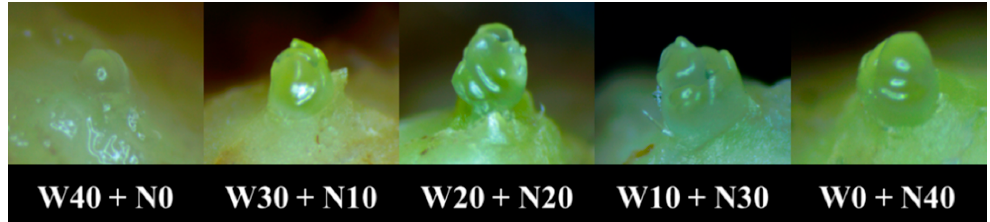
Figure 2. Microscopic view of flower bud development stages on the apical meristem of “Maehyang” strawberry runner plants affected by the nutrient solution resupply period on the day of transplanting. Refer to Figure S1 for details on images of flower bud development stages. Refer to Figure 1 for details on nutrient solution resupply periods.